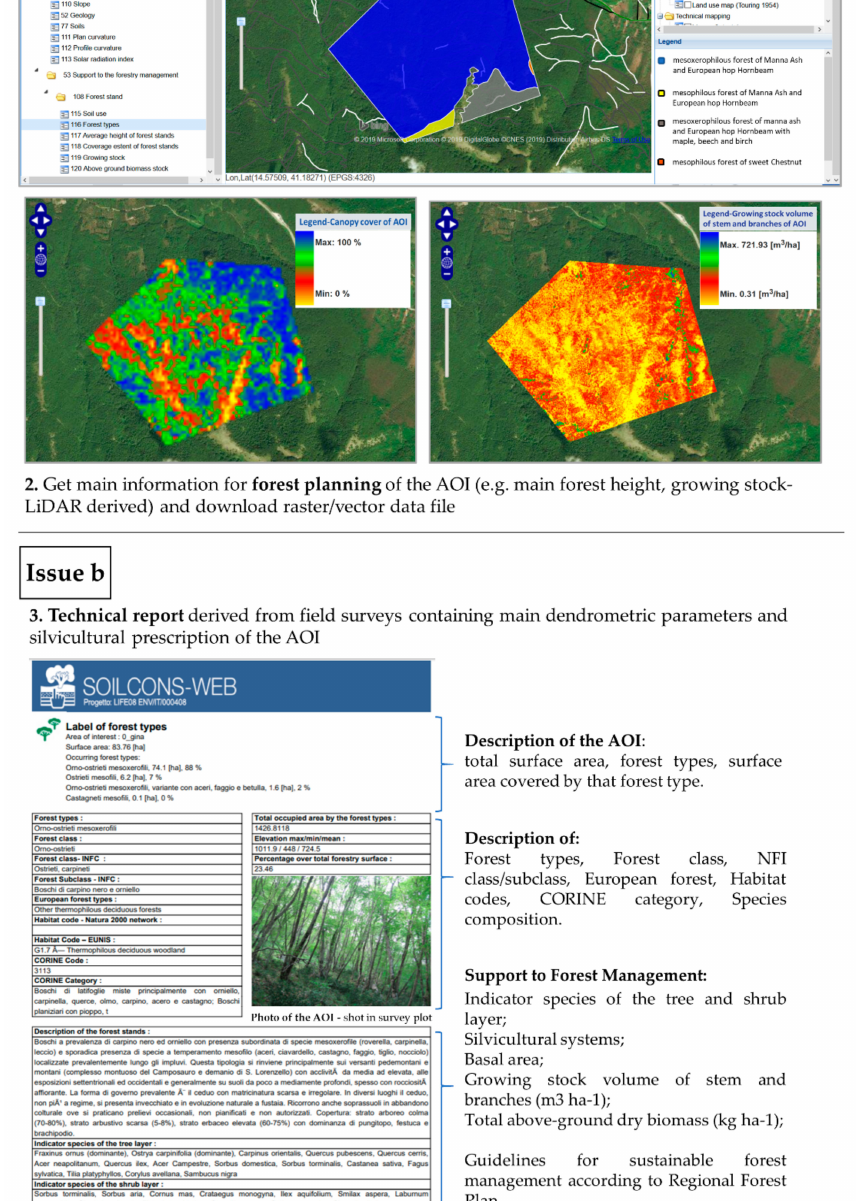
Figure 5. Results from three simulations of the GIFT tool. Three identical areas of interest (AOI) have been generated according to the forest stand information the user was interested to get (canopy cover or growing stock volume). Accordingly, a technical report has been created with information of the AOI. The original information is in Italian (here translated manually in English) since the platform has been designed for Italian forest owner